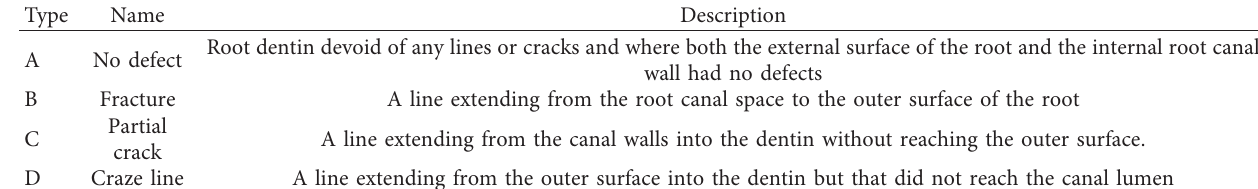
Table 1: Nomenclature and description of specimen categories.